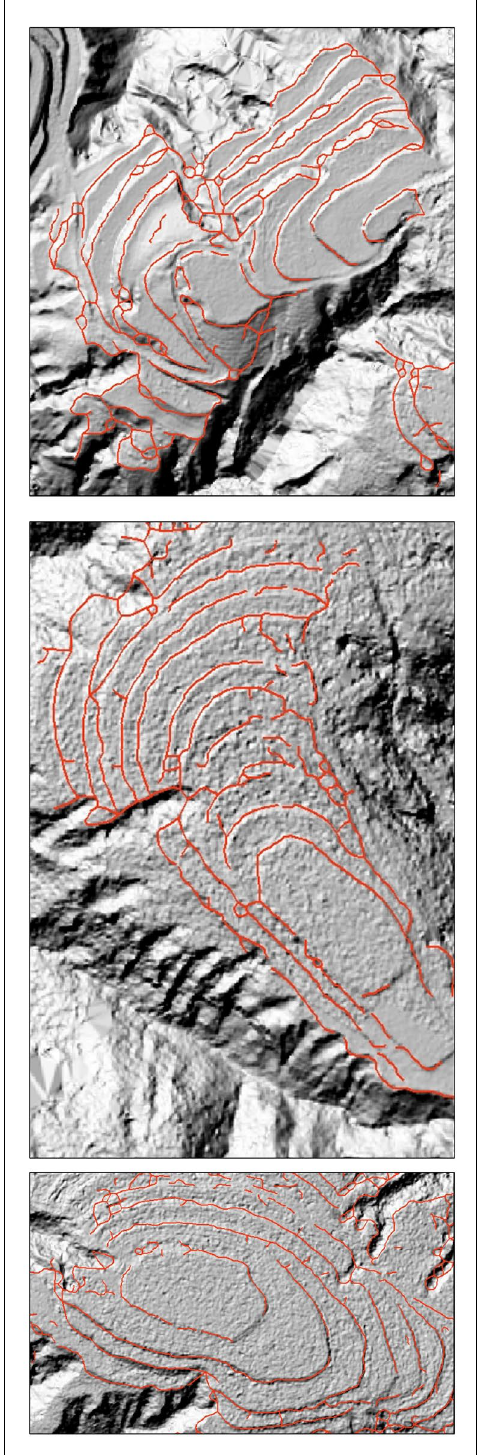
Figure 6. Final result